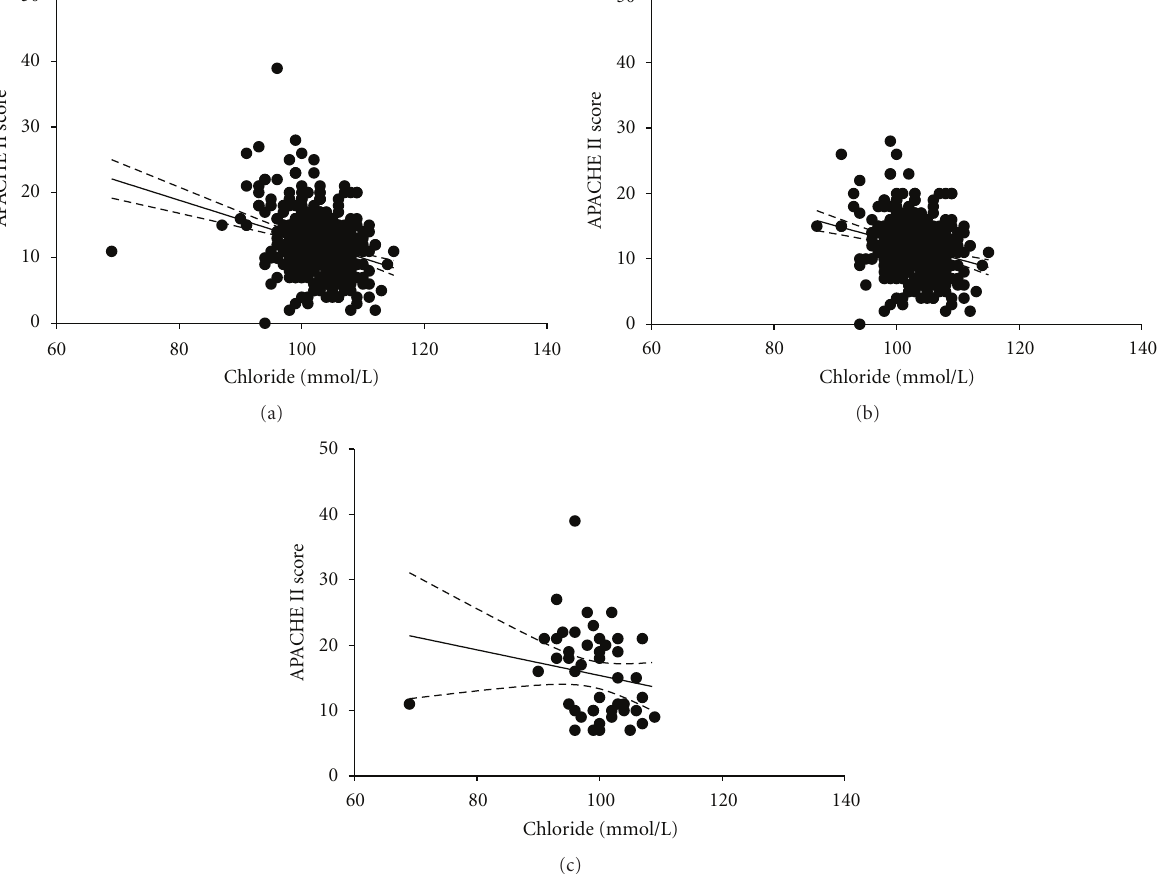
Figure 2: Relationship between chloride and APACHE II score. The solid line represents the linear regression line, and the dotted line represents the 95% confidence band. (a) Total study population. (b) Surgical patients. (c) Medical